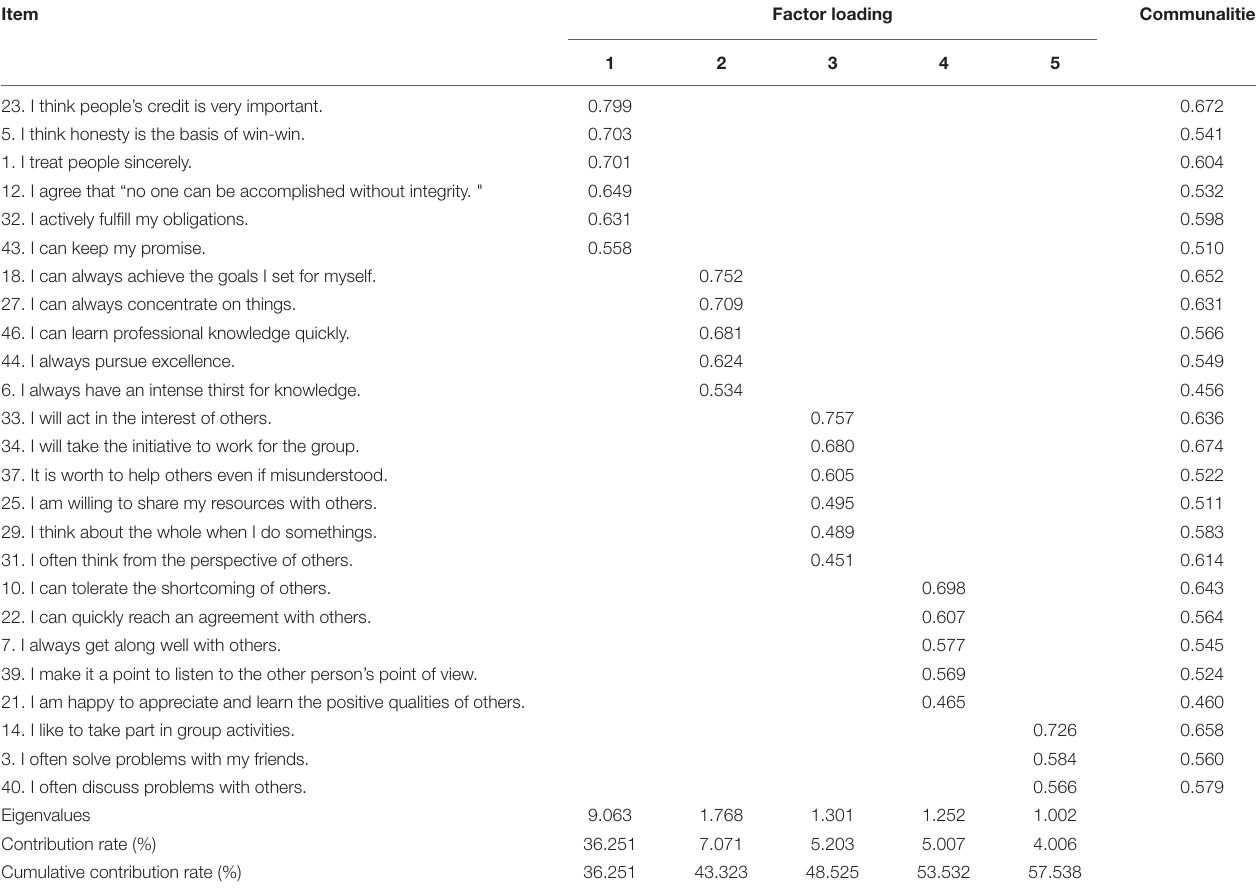
TABLE 1 | Factor analysis matrix of win-win. Item